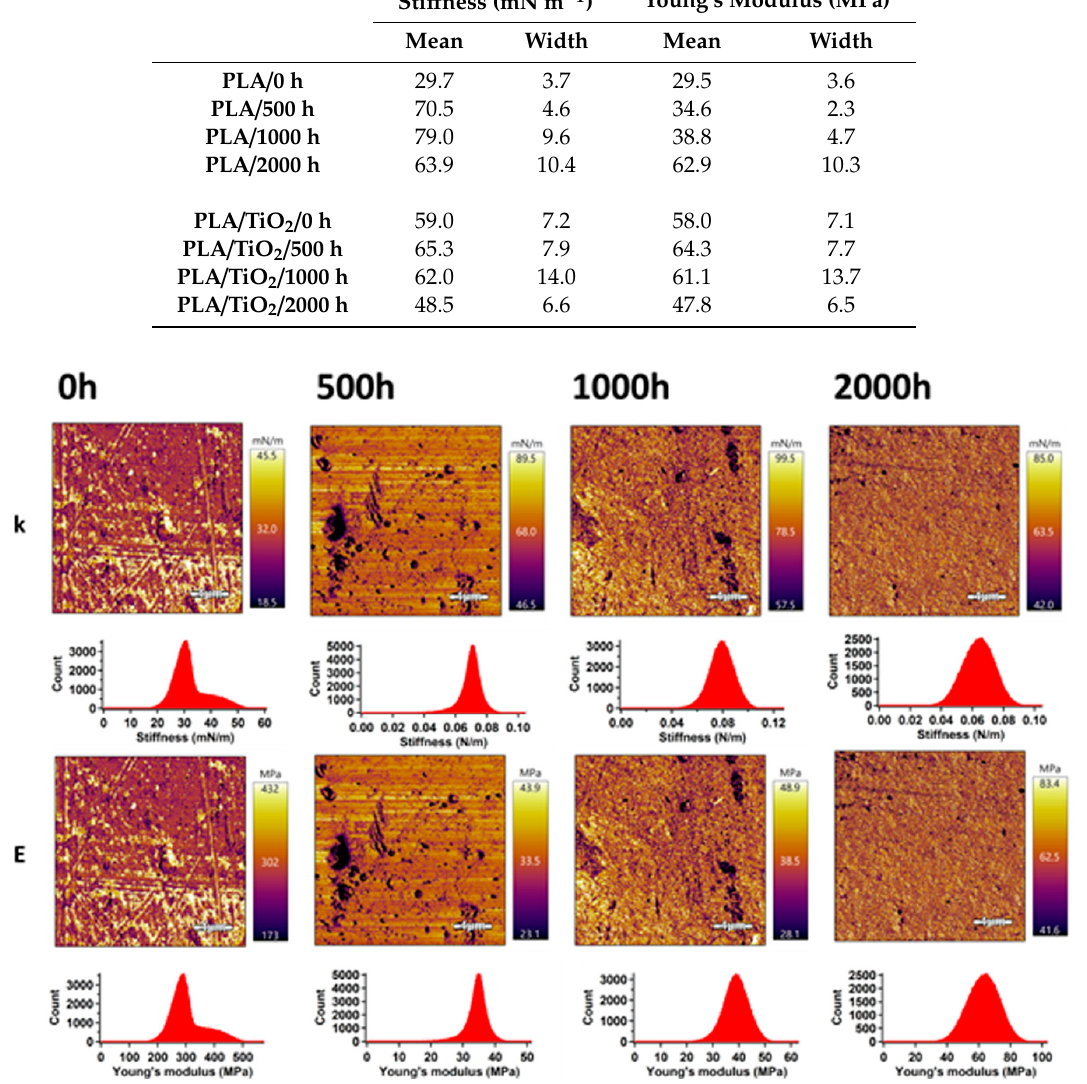
Table 1. Mechanical properties of PLA and PLA / TiO 2 nanocomposite collected from AFM analyses.